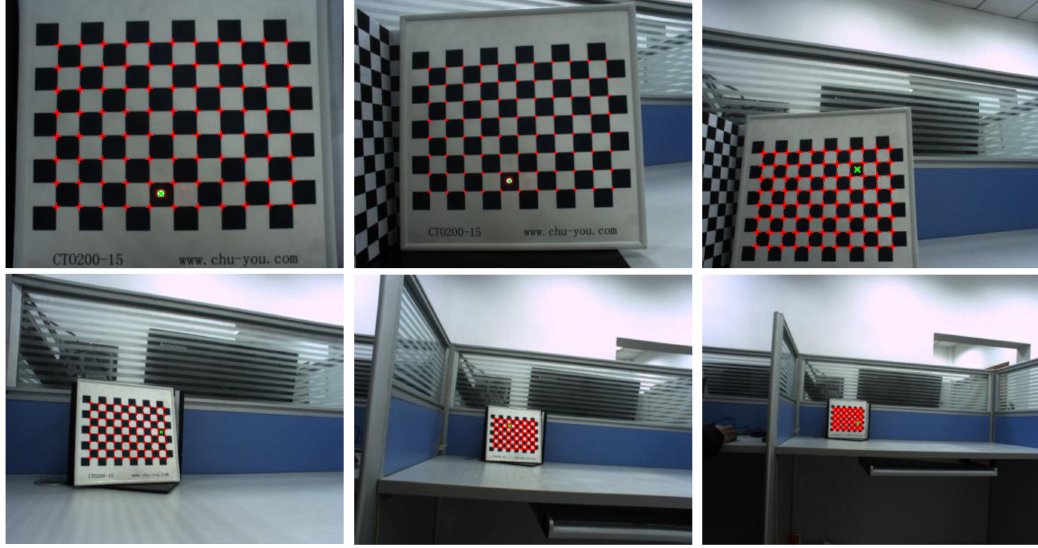
Figure 8. Samples of images used for the real